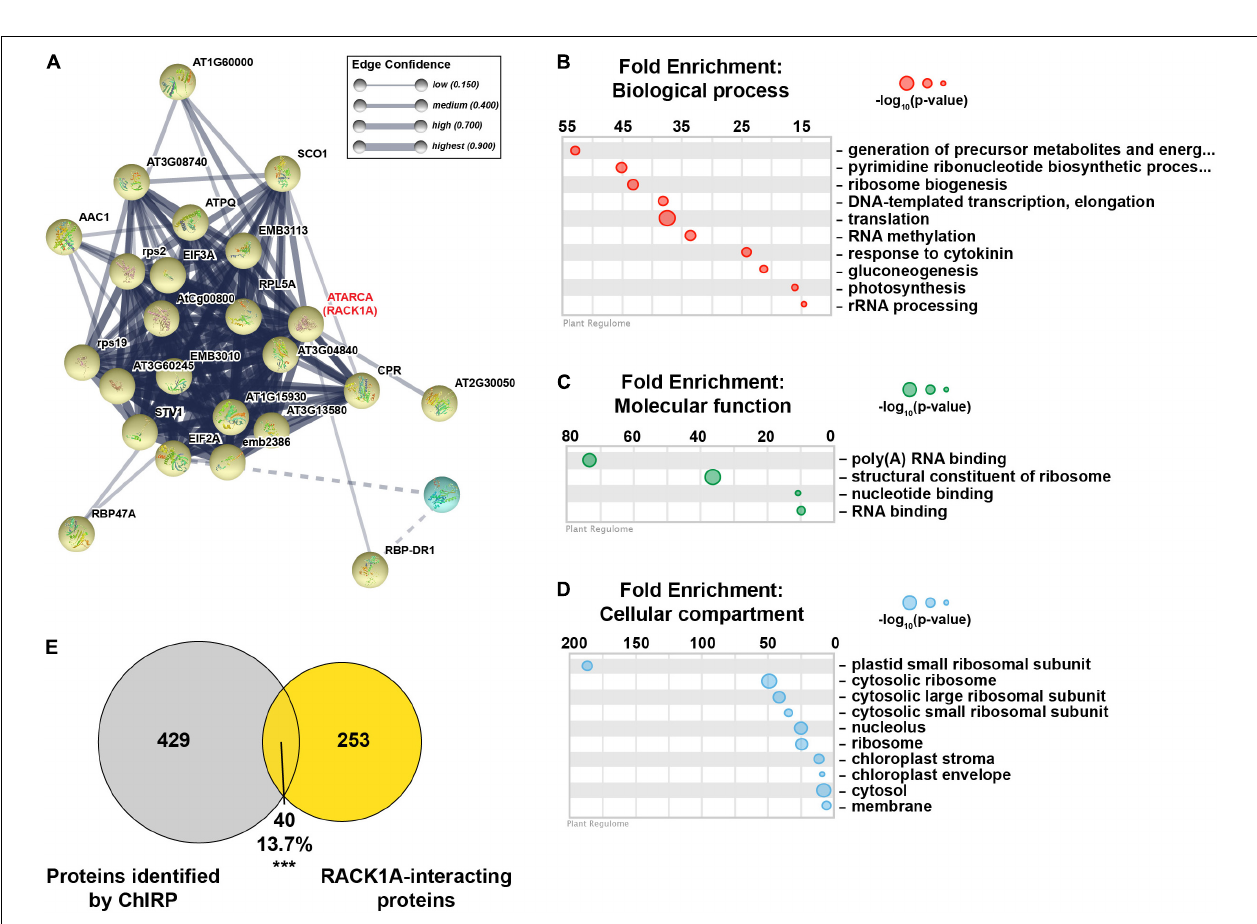
FIGURE 5 | lncCOBRA1 interacts with RACK1A and a tight network of proteins related to ribosome biogenesis. (A) Yellow protein-protein interaction k-means cluster generated from STRING (Szklarczyk et al., 2019). Thickness of lines connecting notes indicates the confidence of that protein–protein interaction. Dotted line indicates interaction with a different cluster (see Supplementary Figure 7 for full network). (B–D) Gene ontology enrichment analysis for biological process (B) , molecular function (C) , and cellular compartment (D) using Plant Regulomics (Ran et al., 2020) for lncCOBRA1 -interacting proteins in the yellow cluster. Size of circles represents –log 10 ( p -value). (E) Overlap between proteins identified in at least two biological replicates of Col-0 ChIRP with the lncCOBRA1 probes and proteins identified as RACK1A binding. *** denotes p -value < 0.001; Hypergeometric test.